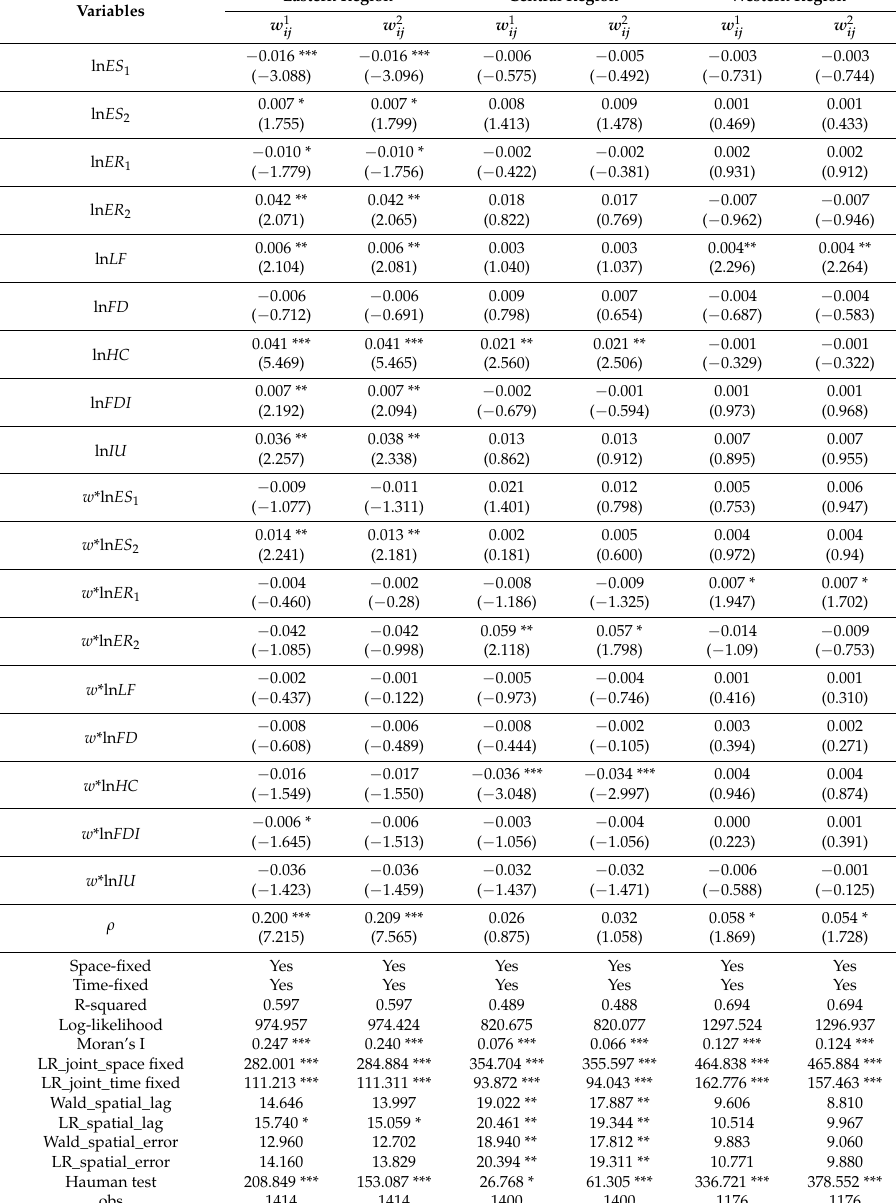
Table 6. The results of the sub-regional